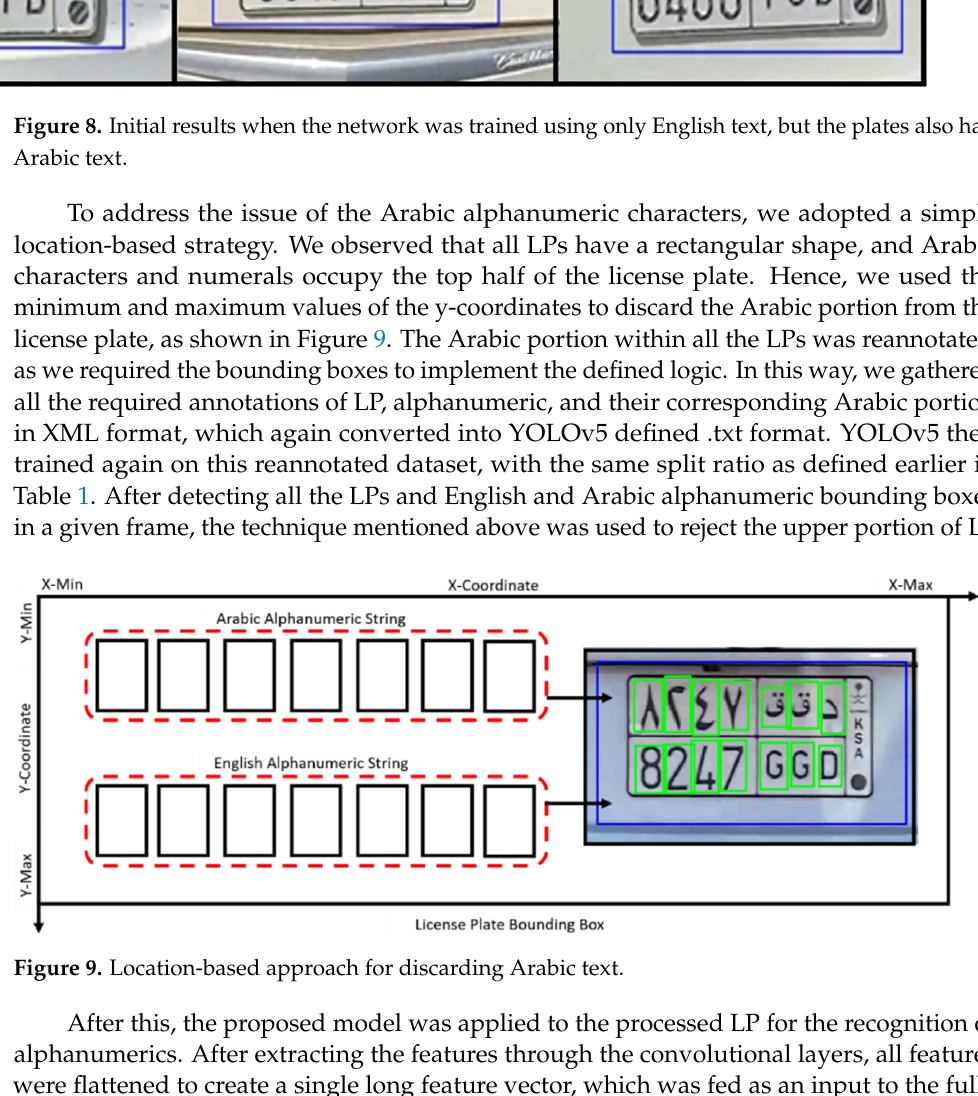
Figure 9. Location-based approach for discarding Arabic text.